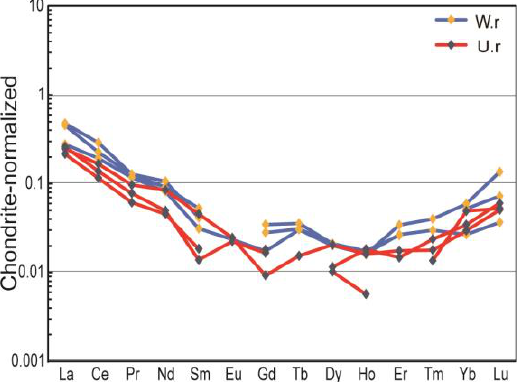
Figure 7. Chondrite normalized trace element spider diagrams for samples [36].